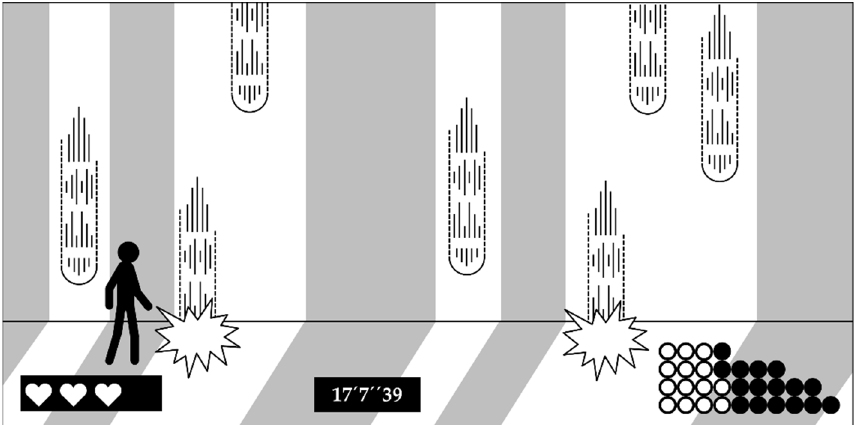
Figure 3. Mockup of the player’s screen while playing the example of a game that successfully presents a dynamic analog dilemma through the behavior of the stamina in-game resource.